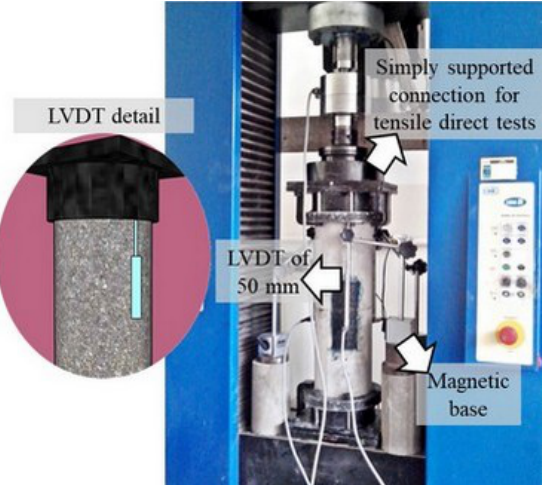
Figure 3. Apparatus with internal diameter of 150 mm for conducting direct tensile tests.